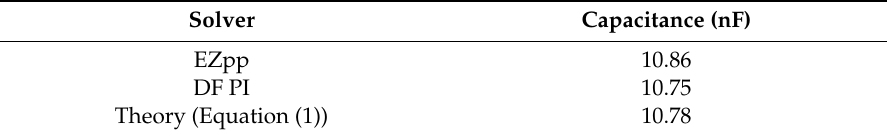
Figure 2. Z in computed without decoupling capacitances by EZpp (red line) and from DF PI (blue line). Table 2. Capacitance value extracted at 1 MHz from Z in (Figure